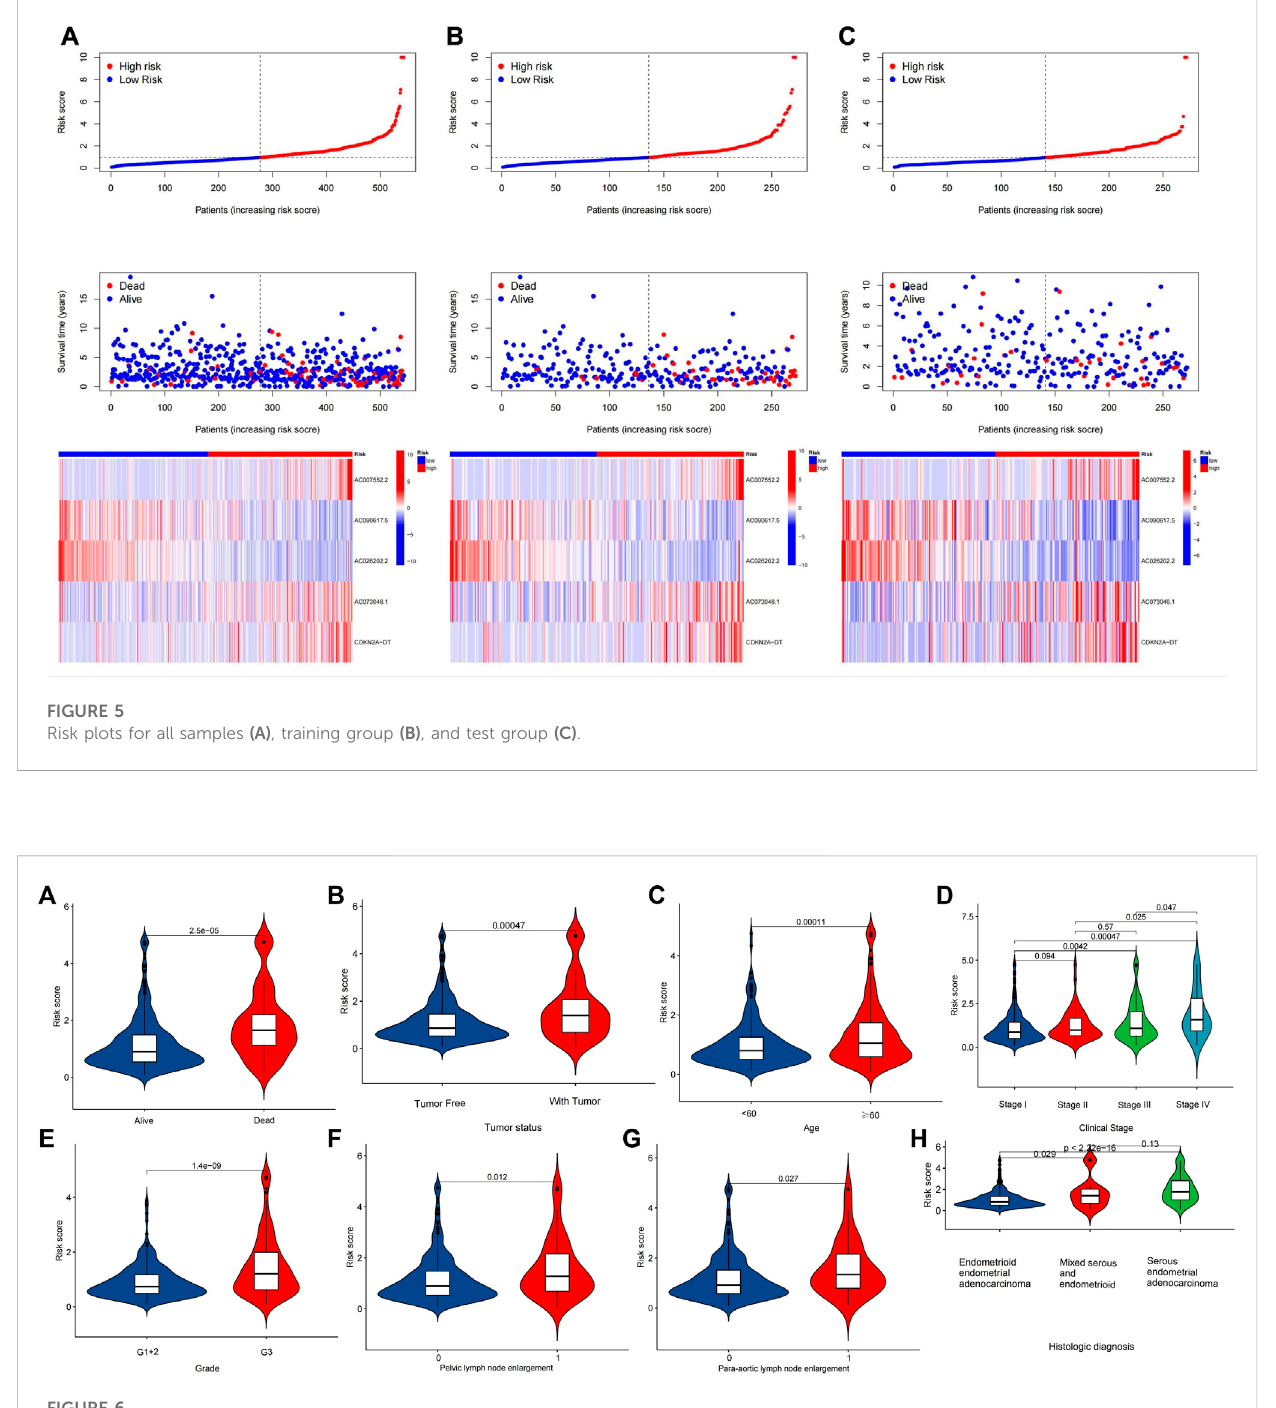
FIGURE 6 Relationship between Cuproptosis-related LncRNA signature and clinical characteristics. Analysis of diferences in risk scores between patients with diferentsurvivalstatus (A) ,recurrencestatus (B) ,age (C) ,stage (D) ,grade (E) ,pelviclymphnodeenlargement (F) ,para-aorticlymphnodeenlargement (G) , Histological diagnosis (H)